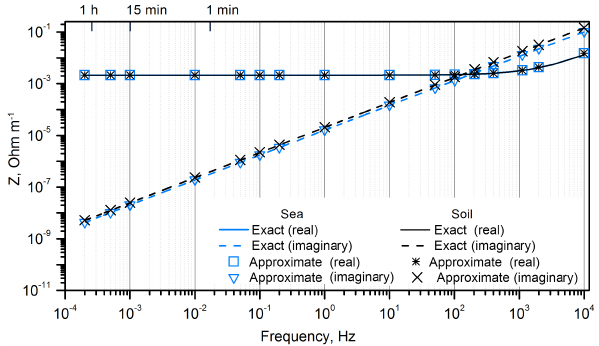
Figure 8. The frequency dependence of impedance of the copper cable in sea water with conductivity of 1Sm − 1 and in soil with conductivity of 10 − 3 Sm − 1 , calculated by the exact (lines) and ap- proximate (scatter) methods.